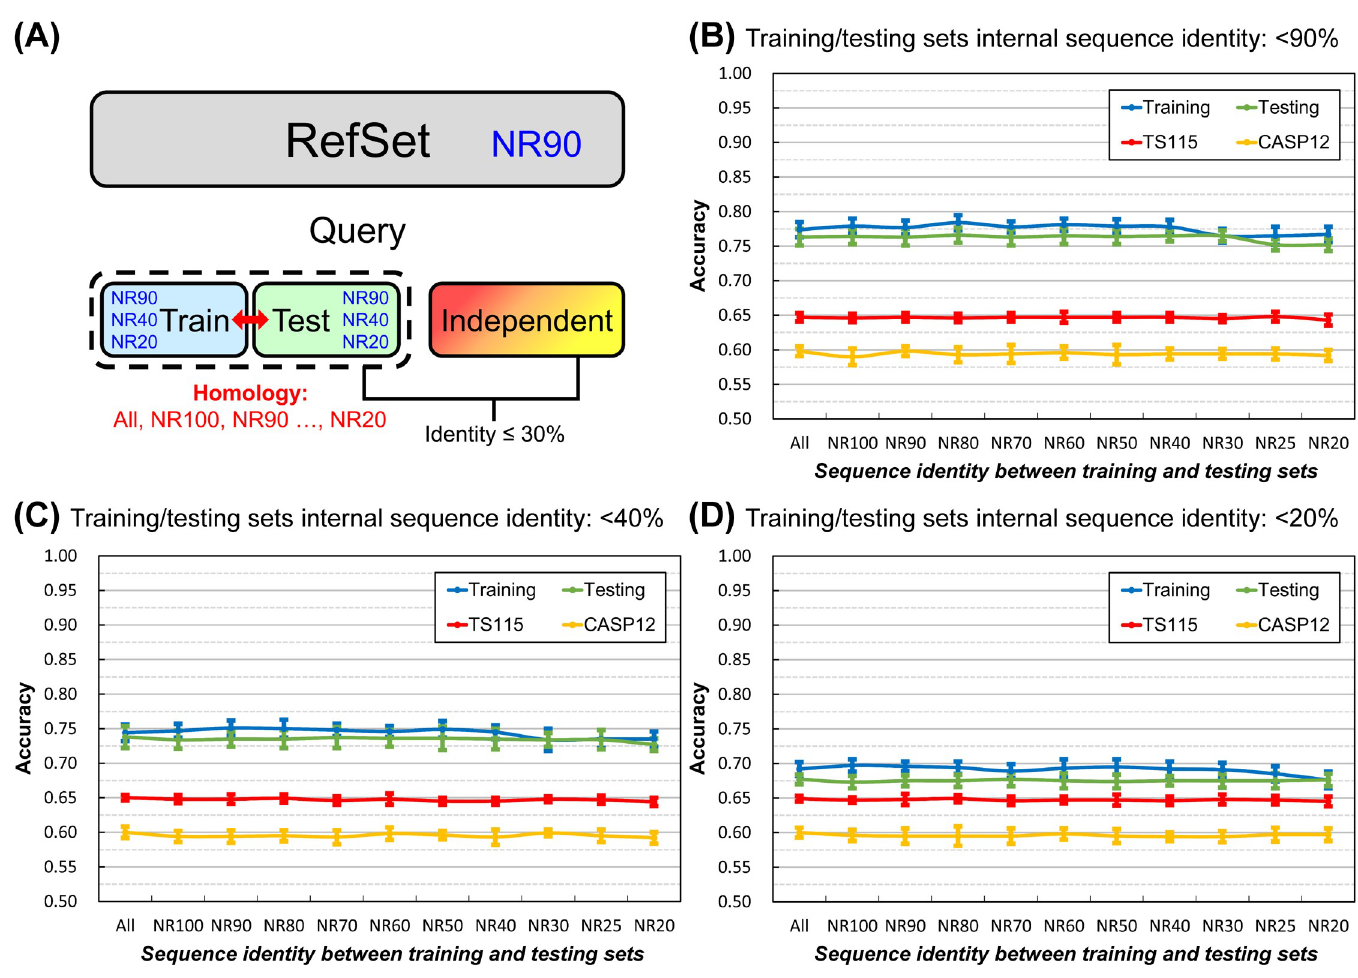
Fig 1. Effects of the homology between training and testing query datasets on the accuracy of secondary structure prediction. (A) The layout of datasets. The NR x indicates the non-redundancy of sequences in one or between two datasets, where x is the sequence identity cutoff. For example, the NR90 labeled on the reference dataset (RefSet) indicates that any two sequences’ identity in the dataset was < 90%. In this layout, the homology between training and testing query sets decreased while the individual query set’s homology was fixed at 90%, 40%, or 20% identity cutoffs. All proteins in the reference and training/testing sets were obtained from the 2015 PDB. Dataset size: reference 10,000, training 250, testing 250. The independent test datasets, TS115 [44] and CASP12 [42], consisted of PDB proteins from 2016 or later with low homology with the 2015 PDB. (B) Results of decreasing inter-dataset homology with fixed inner dataset homology ( < 90%). (C) Results of decreasing inter- dataset homology with fixed inner dataset homology ( < 40%). (D) Results of decreasing inter-dataset homology with fixed inner dataset homology ( < 20%). Unlike the assumption of previous studies, the homology between training and testing query sets exhibited little influence on SSP accuracy, no matter in training, testing, or independent tests. Repeating this experiment at three inner-dataset homology levels reached the same conclusion. These independent test accuracies were lower than previous reports ( Materials and Methods ) because the reference set was much smaller than the conventional UniRef90 dataset. For reasons why the accuracy of CASP12 is lower than TS115, see Materials and Methods as